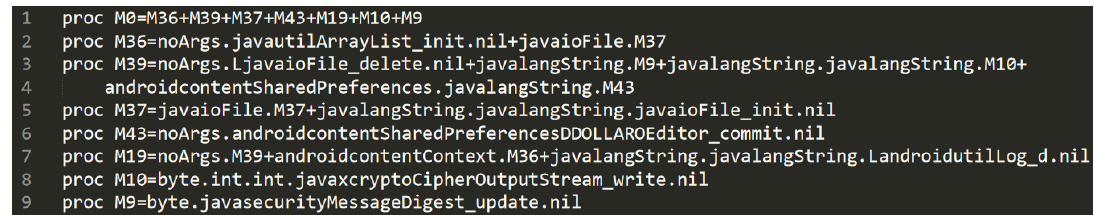
Figure 4. A Call Graph (CG) slice automaton obtained from the Java code shown in Listing 5.